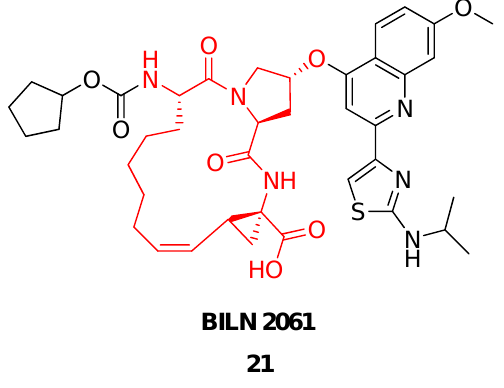
Figure 6. The hepatitis C NS3 protease inhibitor BILN 2061 21 is based on a 15- membered RCM-derived tripeptide macrocycle (highlighted in red) and showed great promise in phase I clinical trials, but eventually did not make it to the